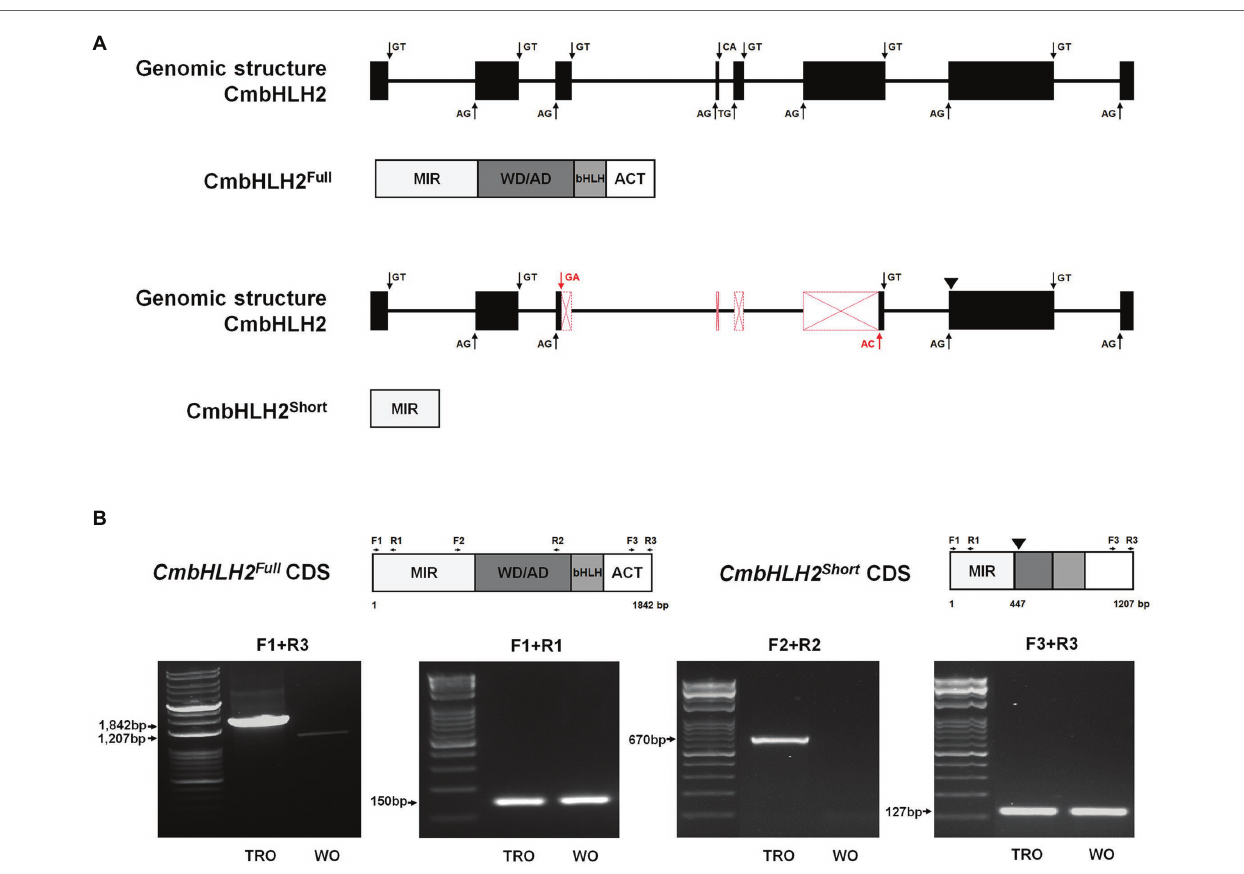
FIGURE 3 | Genomic structure and alternative splicing of CmbHLH2 . (A) Diagram of the genomic structure of CmbHLH2 . The CmbHLH2 Full and CmbHLH2 Short transcripts were generated by canonical splicing (black arrow) and alternative splicing (red arrow) of CmbHLH2 . Protein from its mature mRNA is indicated below with functional domains. An inverted triangle indicates the premature stop codon. (B) The amplicons’ representative gel image corresponds to CmbHLH2 Full and CmbHLH2 Short transcripts from TRO and WO ray florets. An inverted triangle indicates the premature stop codon. The primers used in this study are shown as arrows and listed in Supplementary Table S1